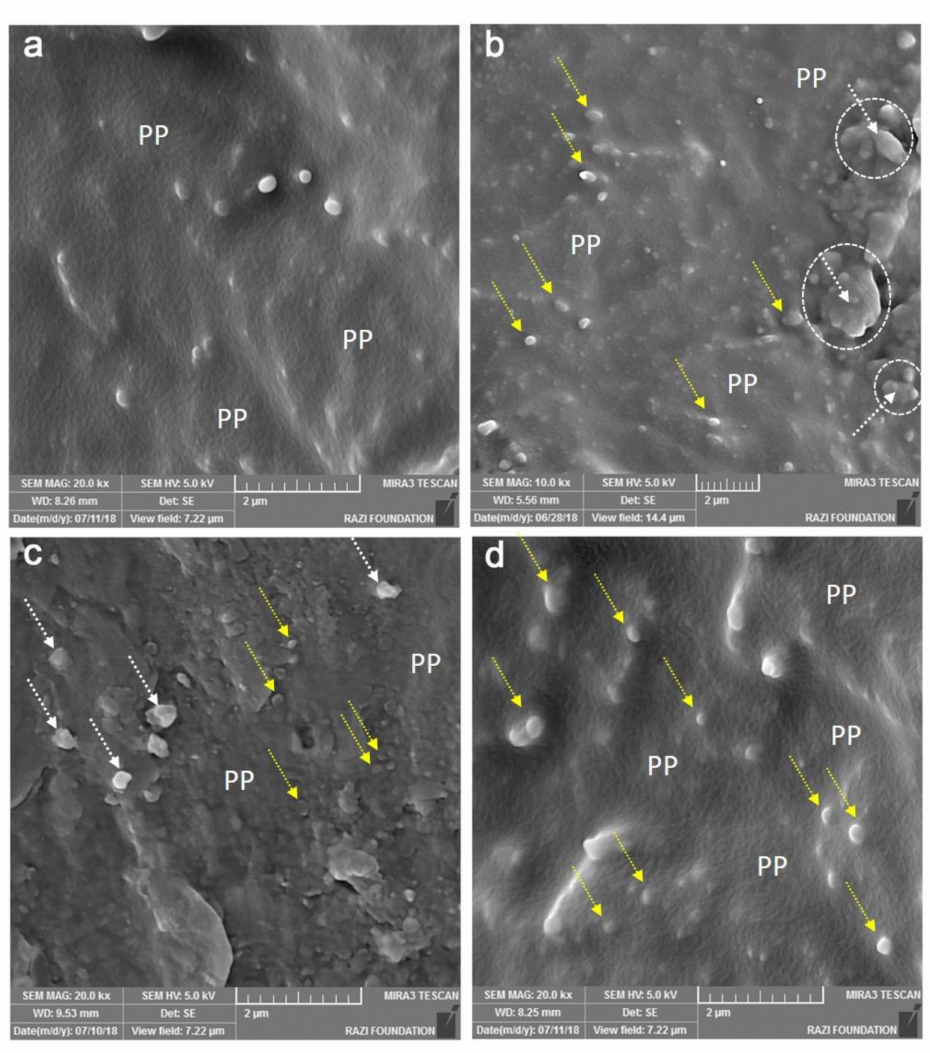
Figure 5. SEM images of pure PP film (control) ( a ) and active composite films: PP-2%SA-1%BHT ( b ); PP-2%SA-3%BHA ( c ); PP-2%SA-1%BHT-1%BHA ( d